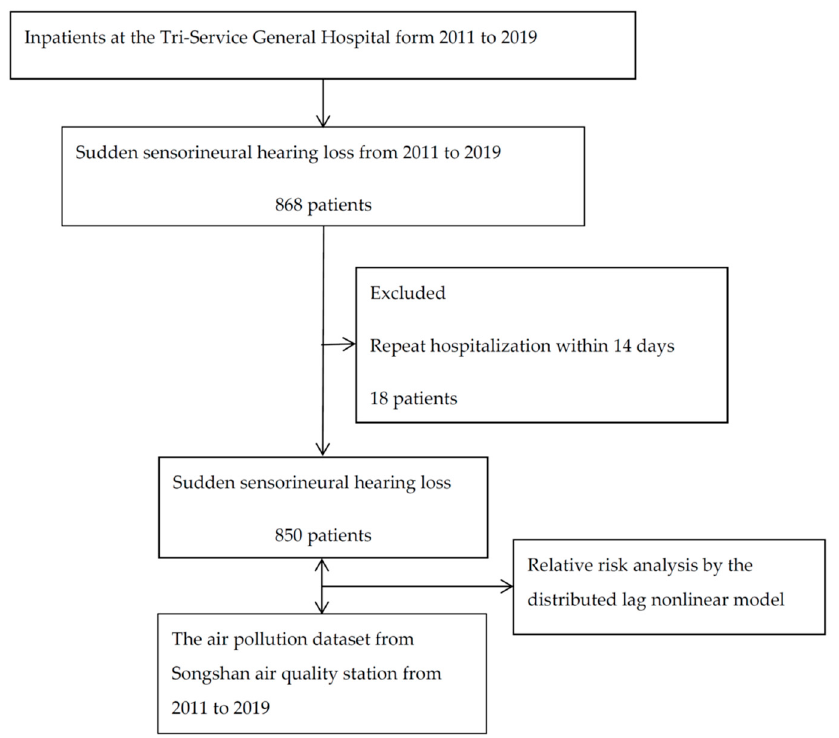
Figure 1. The flowchart for this study.